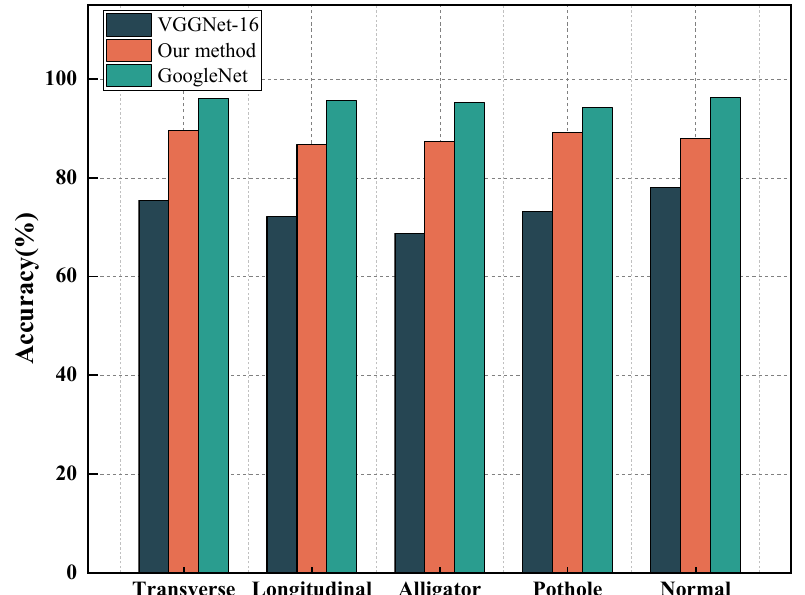
Figure 11. The classification accuracy of this method and the other two classification methods for various types of damage on datasets.